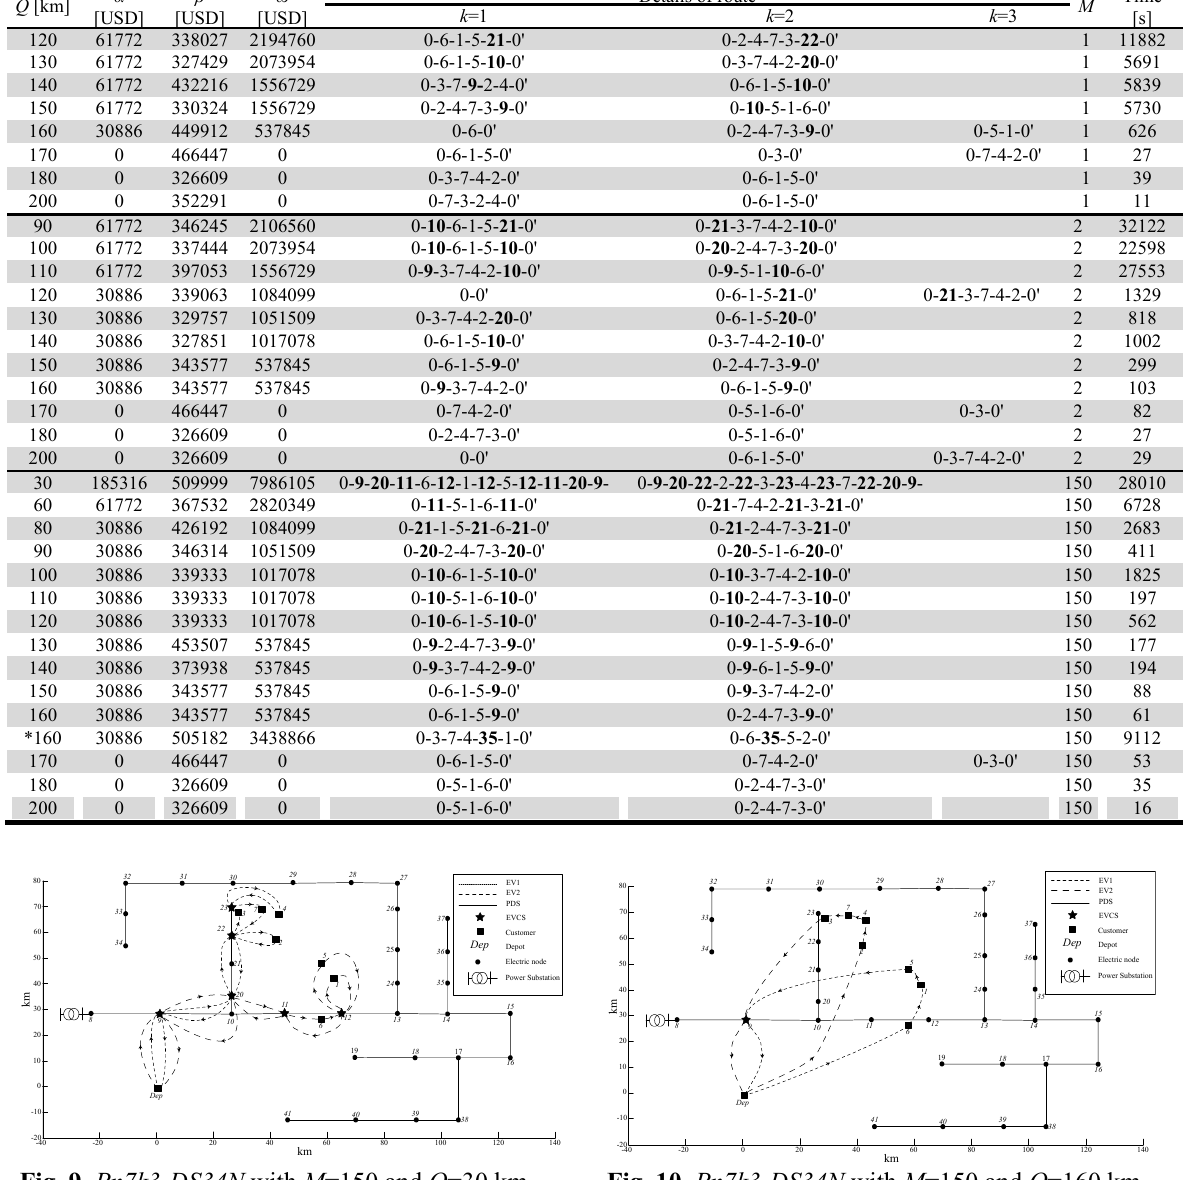
Fig. 9. Pn7k3-DS34N with M =150 and Q =30 km Fig. 10. Pn7k3-DS34N with M =150 and Q =160